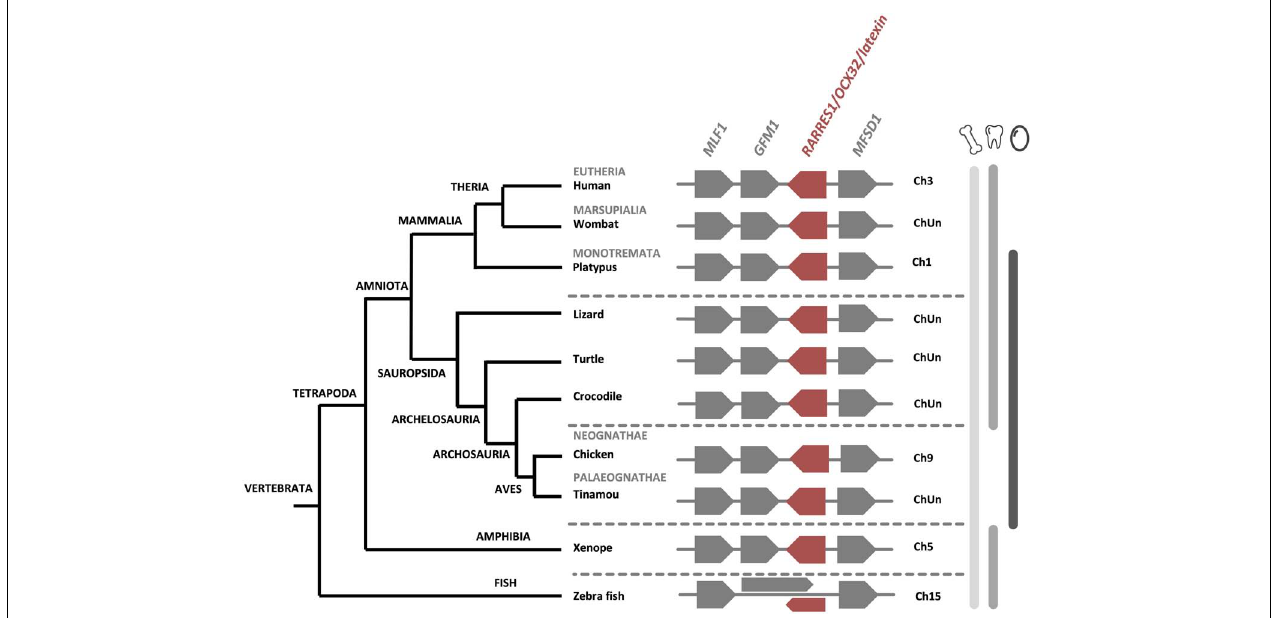
FIGURE 4 | Synteny of RARRES1/OCX32 genes in vertebrates. The RARRES1/OCX32 gene is represented by a red box and the flanking genes MLF1 (myeloid leukemia factor 1), GFM1 (G elongation factor mitochondrial 1) and MFSD1 (major facilitator superfamily domain containing 1) are represented by gray boxes. ChUn, chromosome unknown. Gene IDs are listed in Supplementary Table 2 . The left part of the figure depicts the phylogenetic relationship between vertebrate species (adapted from www.tolweb.org and Kapusta et al.,